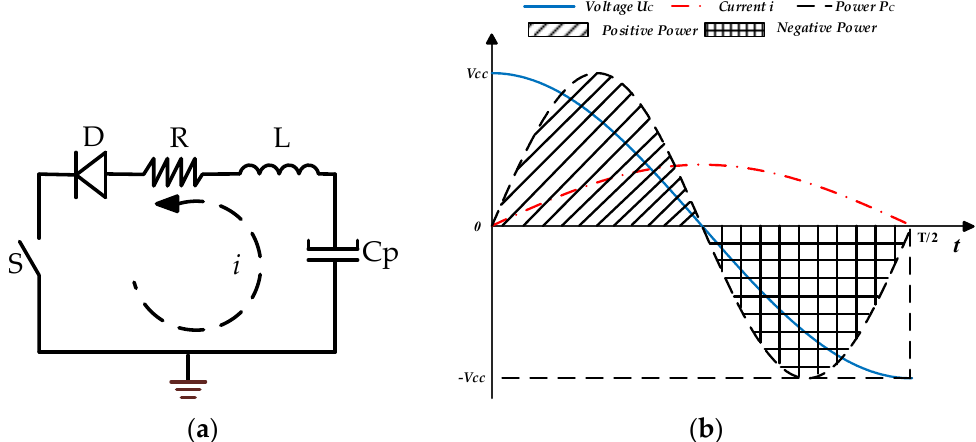
Figure 5. Inductor-based charge recovery strategy. ( a ) Equivalent inductor-based charge recovery circuit; ( b ) Energy conversion between inductor and capacitor.